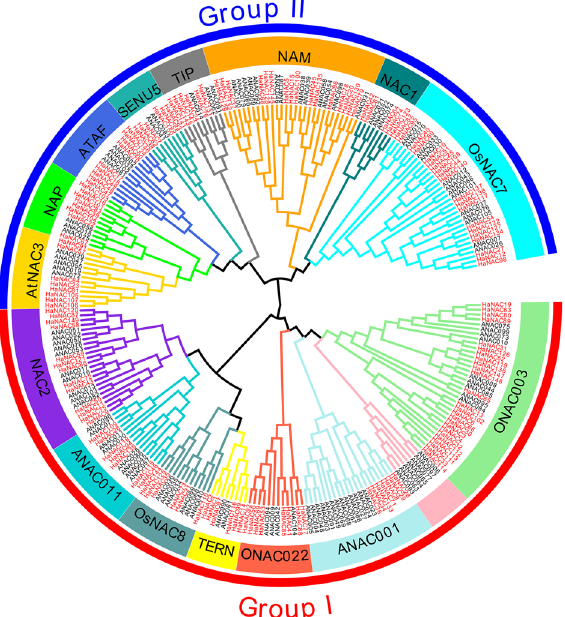
Figure 2. A phylogenetic tree of sunflower and Arabidopsis NAC proteins. The amino acid sequences of NAC proteins were aligned using the ClustalW of MEGA X, and a phylogenetic tree was generated using the neighbor-joining method with 1000 bootstrap replicates in MEGA X. Red and black fonts denoted sunflower and Arabidopsis NACs, respectively. All NACs were classified into two groups: Group I (red) and Group II (blue), and 15 subgroups (different colors for each